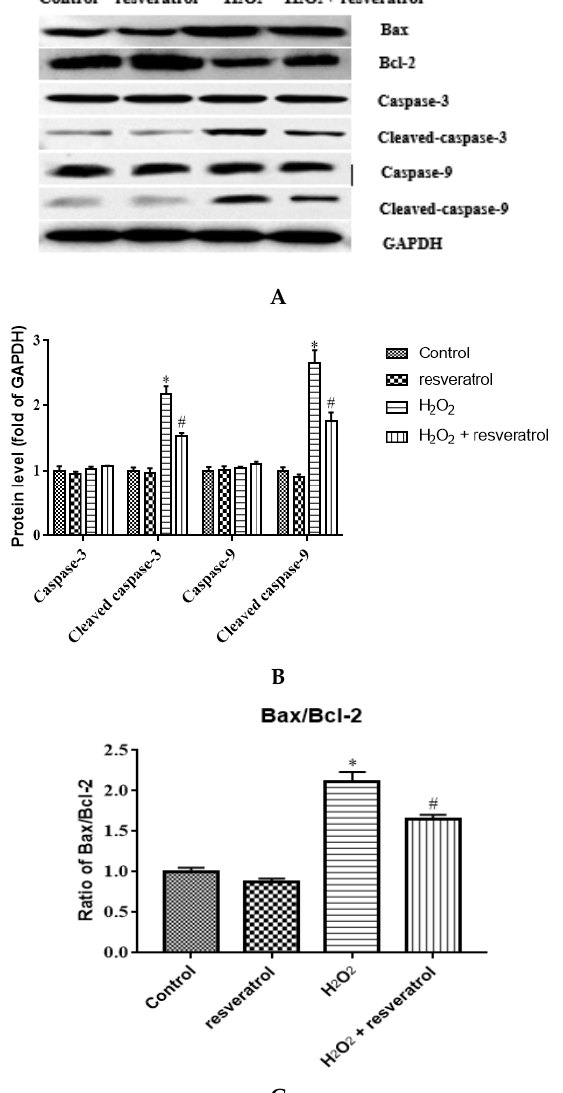
Figure 8. IDECs were pretreated with 5 μM resveratrol for 6 h and then cocultured with 400 μM H 2 O 2 for 6 h. ( A ) Protein levels of Bax, Bcl-2, caspase-3, cleaved caspase-3, caspase-9, and cleaved caspase-9 were detected by Western blot. ( B ) The expression of caspase-3, cleaved caspase-3, caspase-9 and cleaved caspase-9 was quantified by densitometry, and data were normalized to GAPDH. ( C ) Histogram of Bax/Bcl-2 in different treated IDECs. The data were analyzed through one-way ANOVA and are expressed as the mean ± SE ( n = 3). * p < 0.05 compared to control and # p < 0.05 compared to H 2 O 2 group.